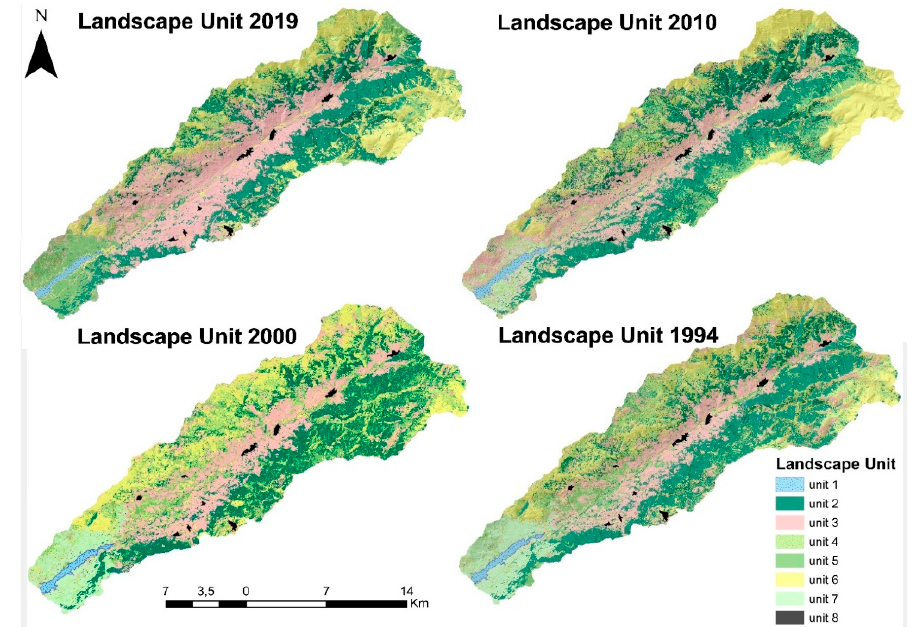
Figure 5. Multi-temporal spatial distribution of the natural units in the study area.